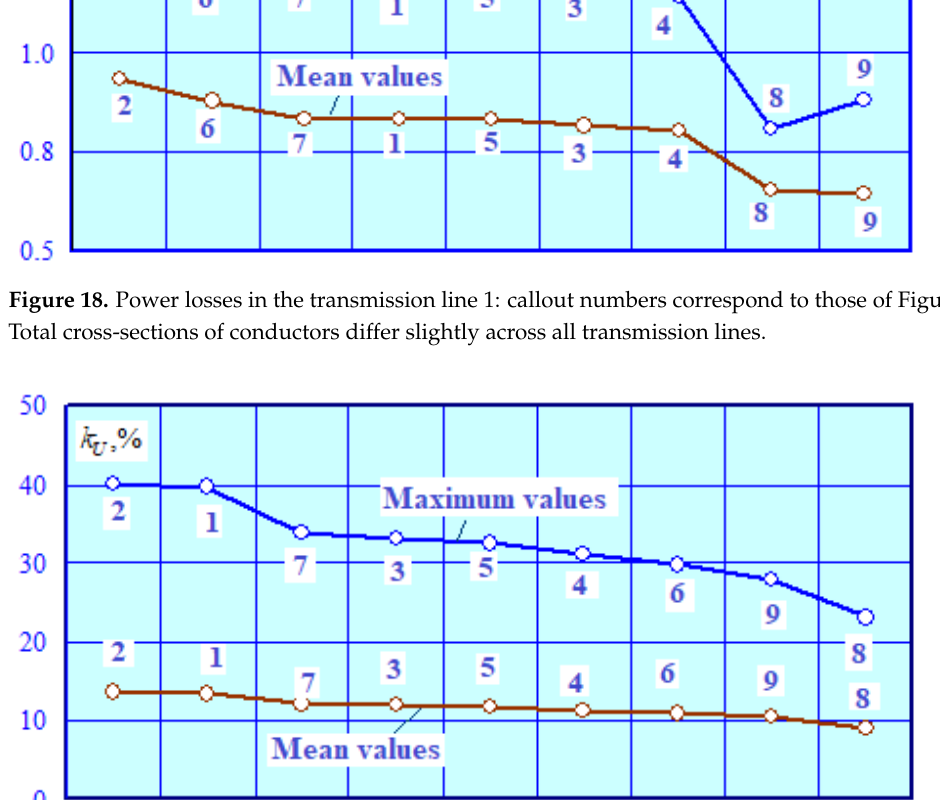
Figure 19. Total harmonic distortion values at the 27.5 kV input of TS No. 4—callout numbers correspond to those in Figure 15.